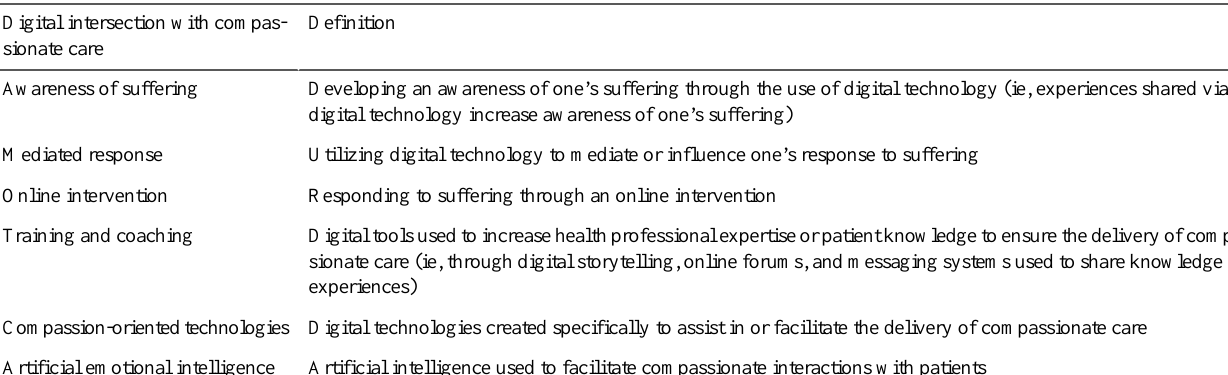
Table 3. Definitions of the digital intersections with compassionate